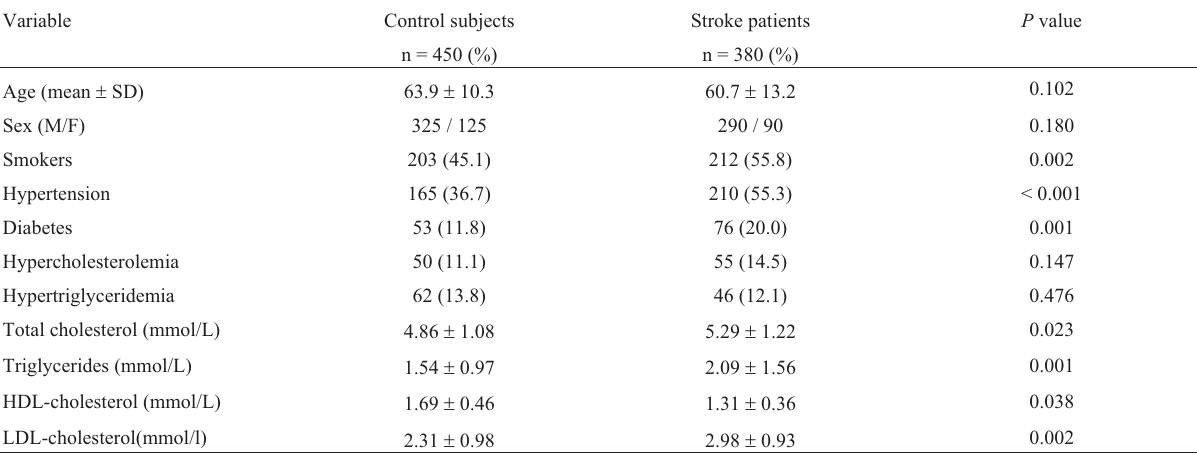
Table 1 - Clinical characteristics of the study participants. Variable Control